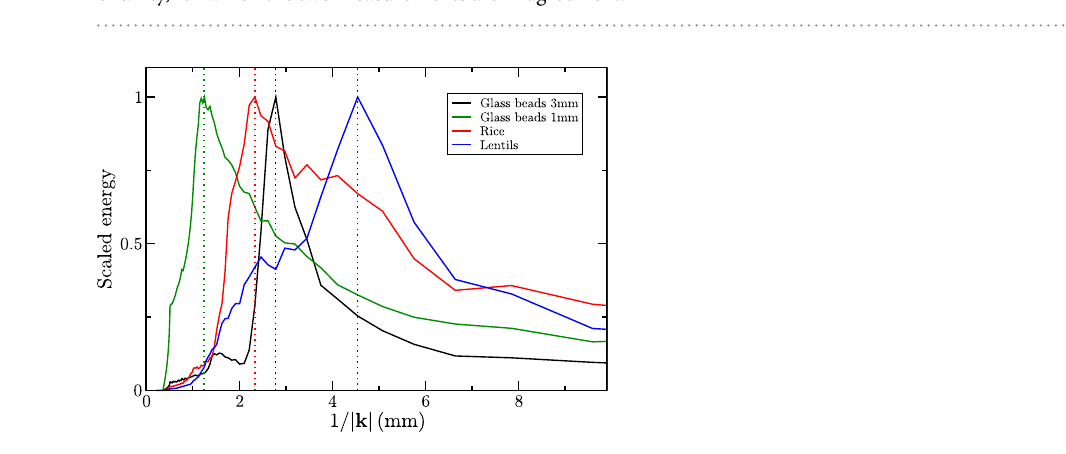
Figure 5. Comparison of the mass flow rate measured by PIV and by mass discharge measurements, for three outlet sizes and three materials, as measured from both A and B projections. The dashed line represents a slope of unity, for which the two measurements are in agreement.